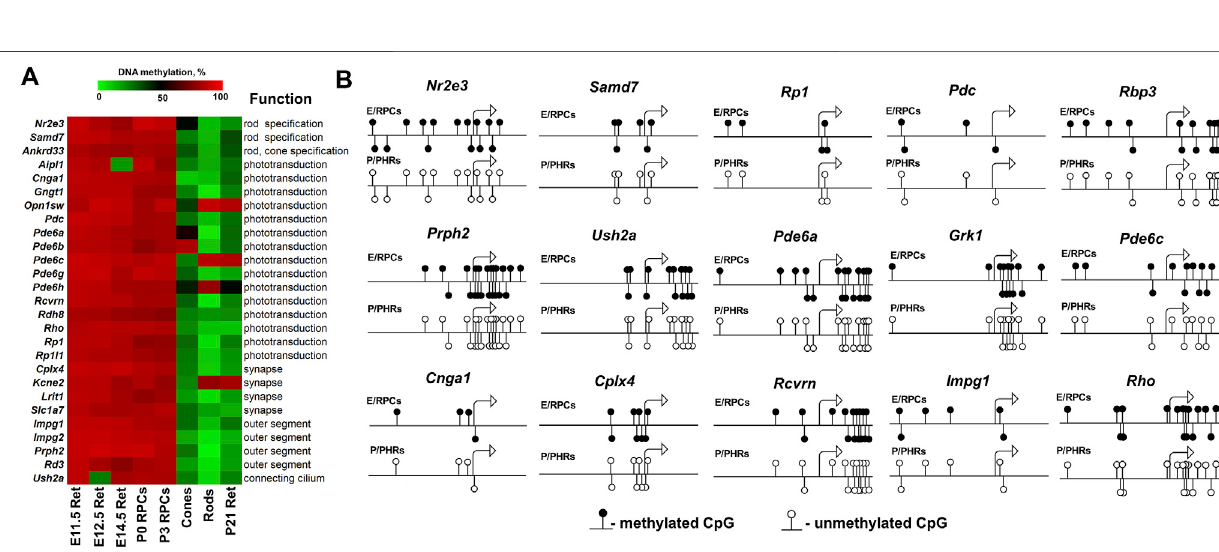
FIGURE 6| The DNA demethylation process is associated with photoreceptor development. (A) Hypermethylated promoters of genes required for photoreceptor speci fi cation/maturation/function show DNA demethylation during the differentiation of RPCs into photoreceptors. (B) The analysis of the methylation dynamics of individualcytosinebasesinthepromoter(1,000bp)and fi rstexon(500bp)regionsofphotoreceptorgenesrevealedthatcytosinesclosetoatranscriptionstartsite(TSS) were mostly affected. (E/RPCs — embryonic retina/RPCs; P/PHRs — postnatal mature